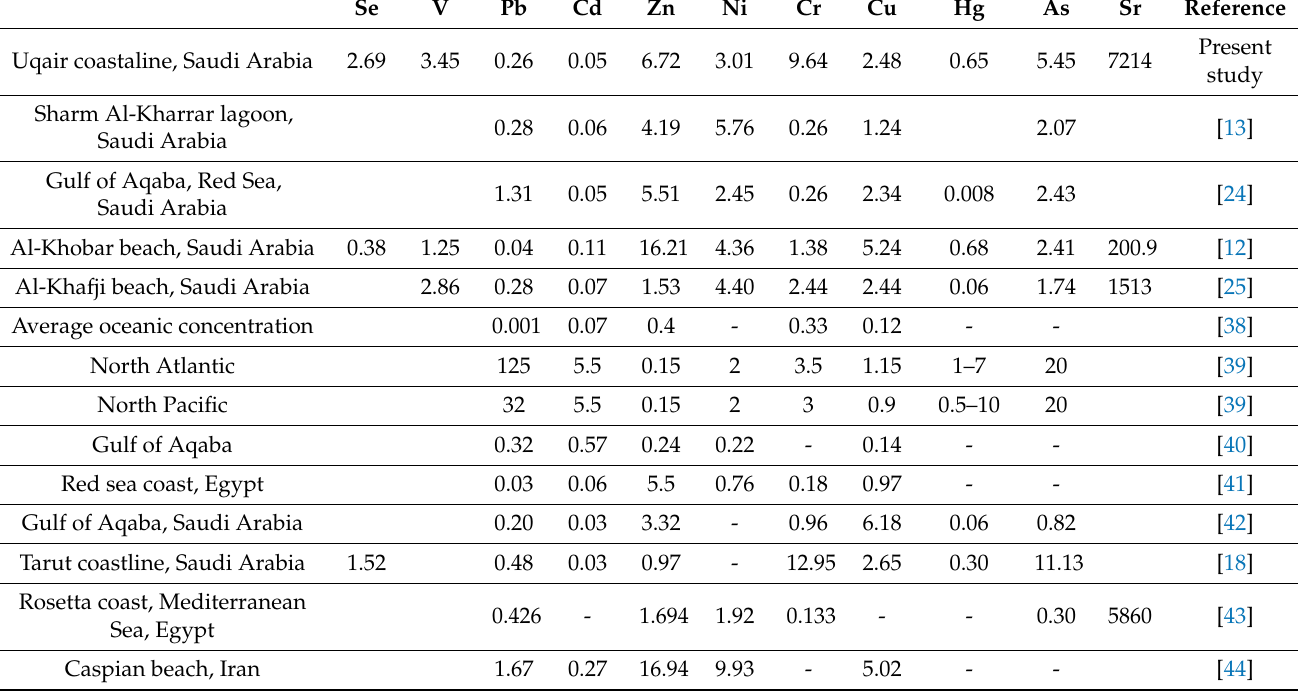
Table 3. Comparison between HM levels in the investigated seawaters and those in other global sites. Se V Pb Cd Zn